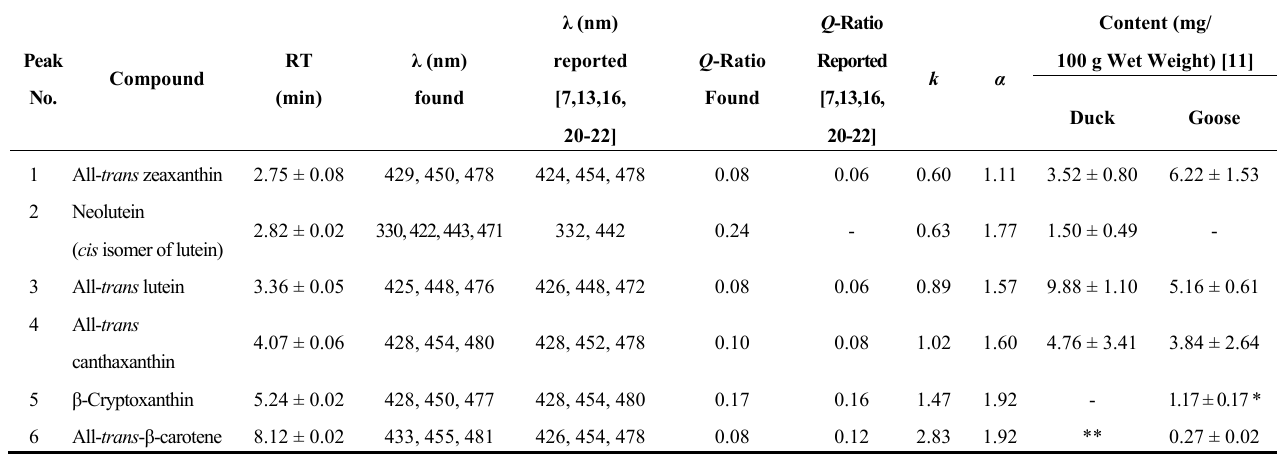
Table 2. Chromatographic identification and quantification data for duck and goose egg yolk